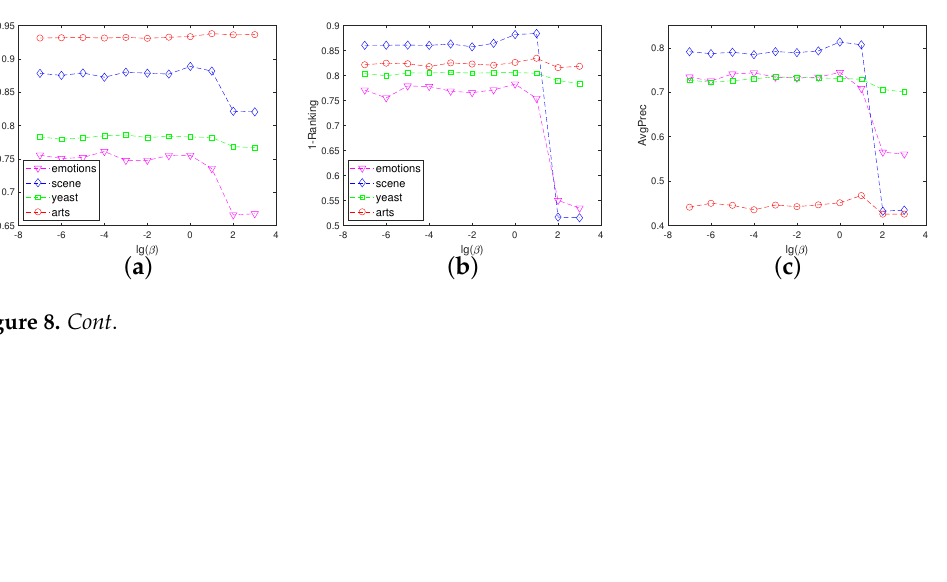
Figure 7. Sensitivity analysis of parameter α on four data sets for five evaluation metrics. ( a ) 1-Hamming. ( b ) 1-Ranking. ( c ) AvgPrec. ( d ) 1-OneError. ( e ) Coverage.